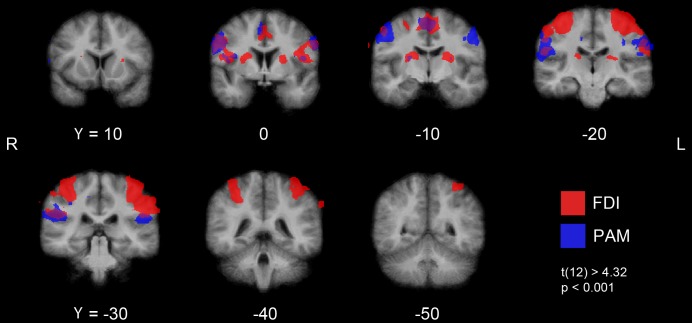
Cortical fMRI activation during PAM and FDI activation.Series of coronar fMRI images at Talairach Y = 10, 0, -10, -20, -30, -40,
-50 with cortical activation during index finger movement (red),
movement of the pinna (blue) and overlapping areas (purple) (P <
0.001; t(12) > 4.32).